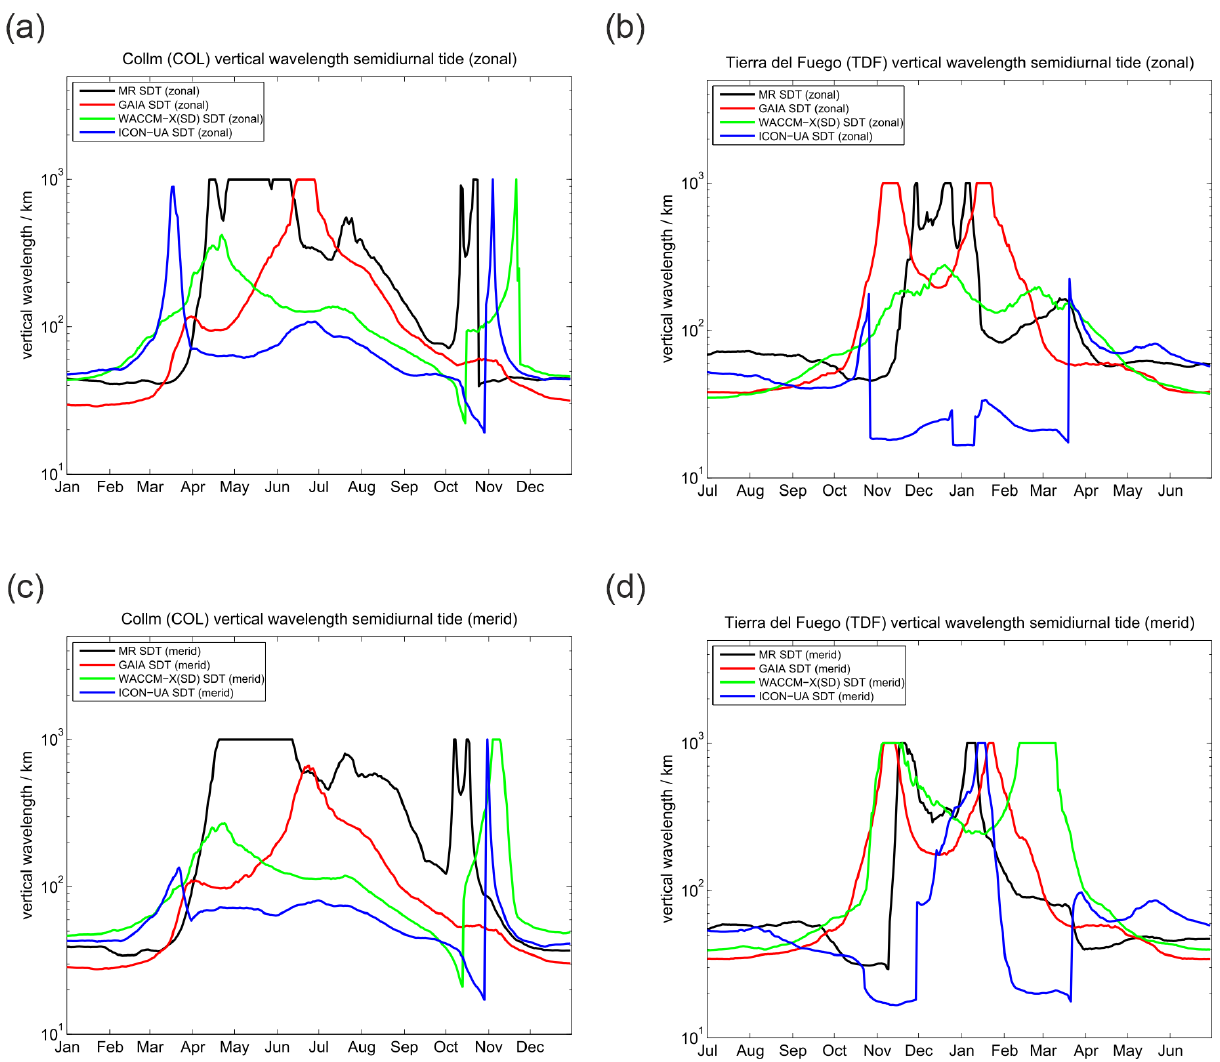
Figure 15. The same as Fig. 8, but for COL and